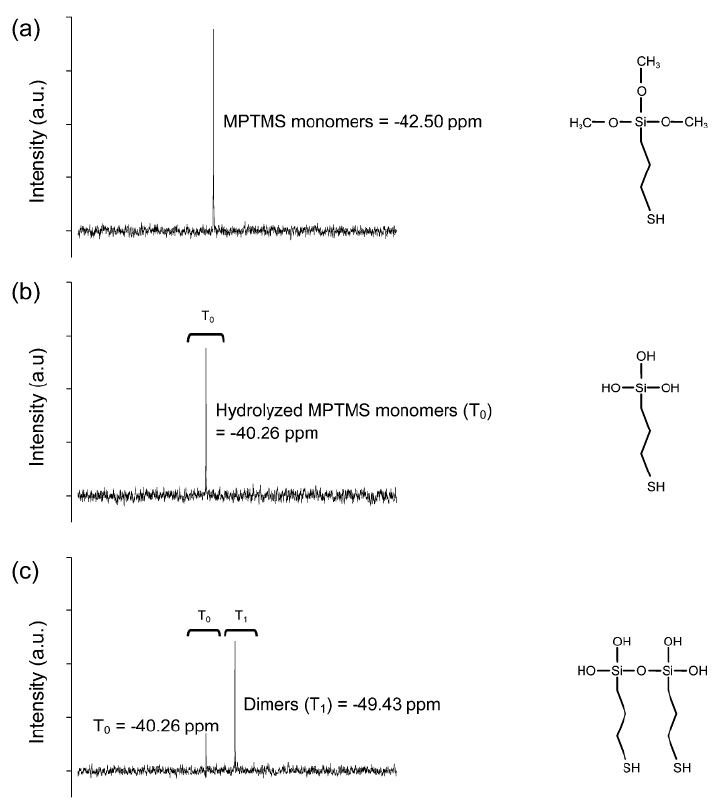
Figure 2. 29 Si nuclear magnetic resonance (NMR) spectra of ( a ) (3-Mercaptopropyl)trimethoxysilane (MPTMS) monomer, ( b ) hydrolyzed MPTMS monomer, ( c ) hydrolyzed MPTMS monomers and dimers.